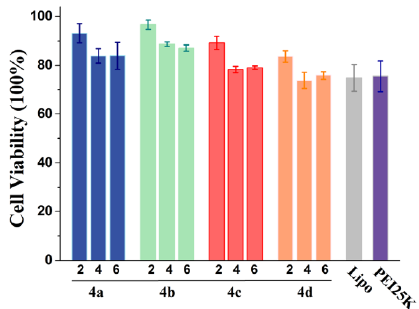
Figure 5. Cytotoxicity of polyplexes at different w / w ratios toward HeLa cells. Lipofectamine 2000 and PEI 25 KDa were used as controls ( w / w = 1.4, N/P = 10). Data are represented by mean ± S.D. ( n =